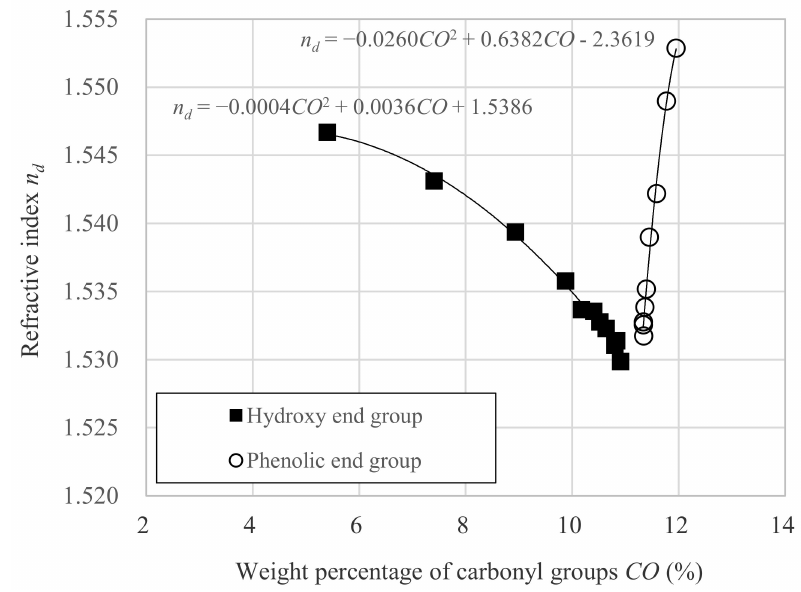
Figure 5. Relation between weight percentage of the carbonyl groups CO and reflective index n